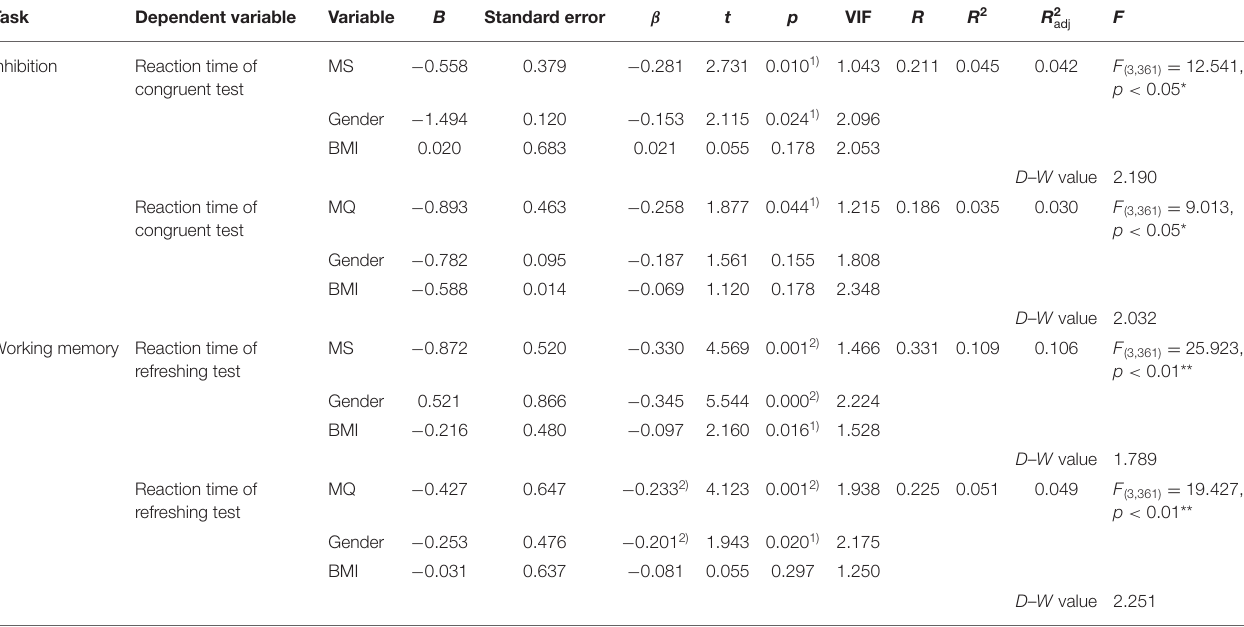
TABLE 3 | Regression analysis of the correlation between gross motor coordination and executive functions of children aged 9–10 years. Task